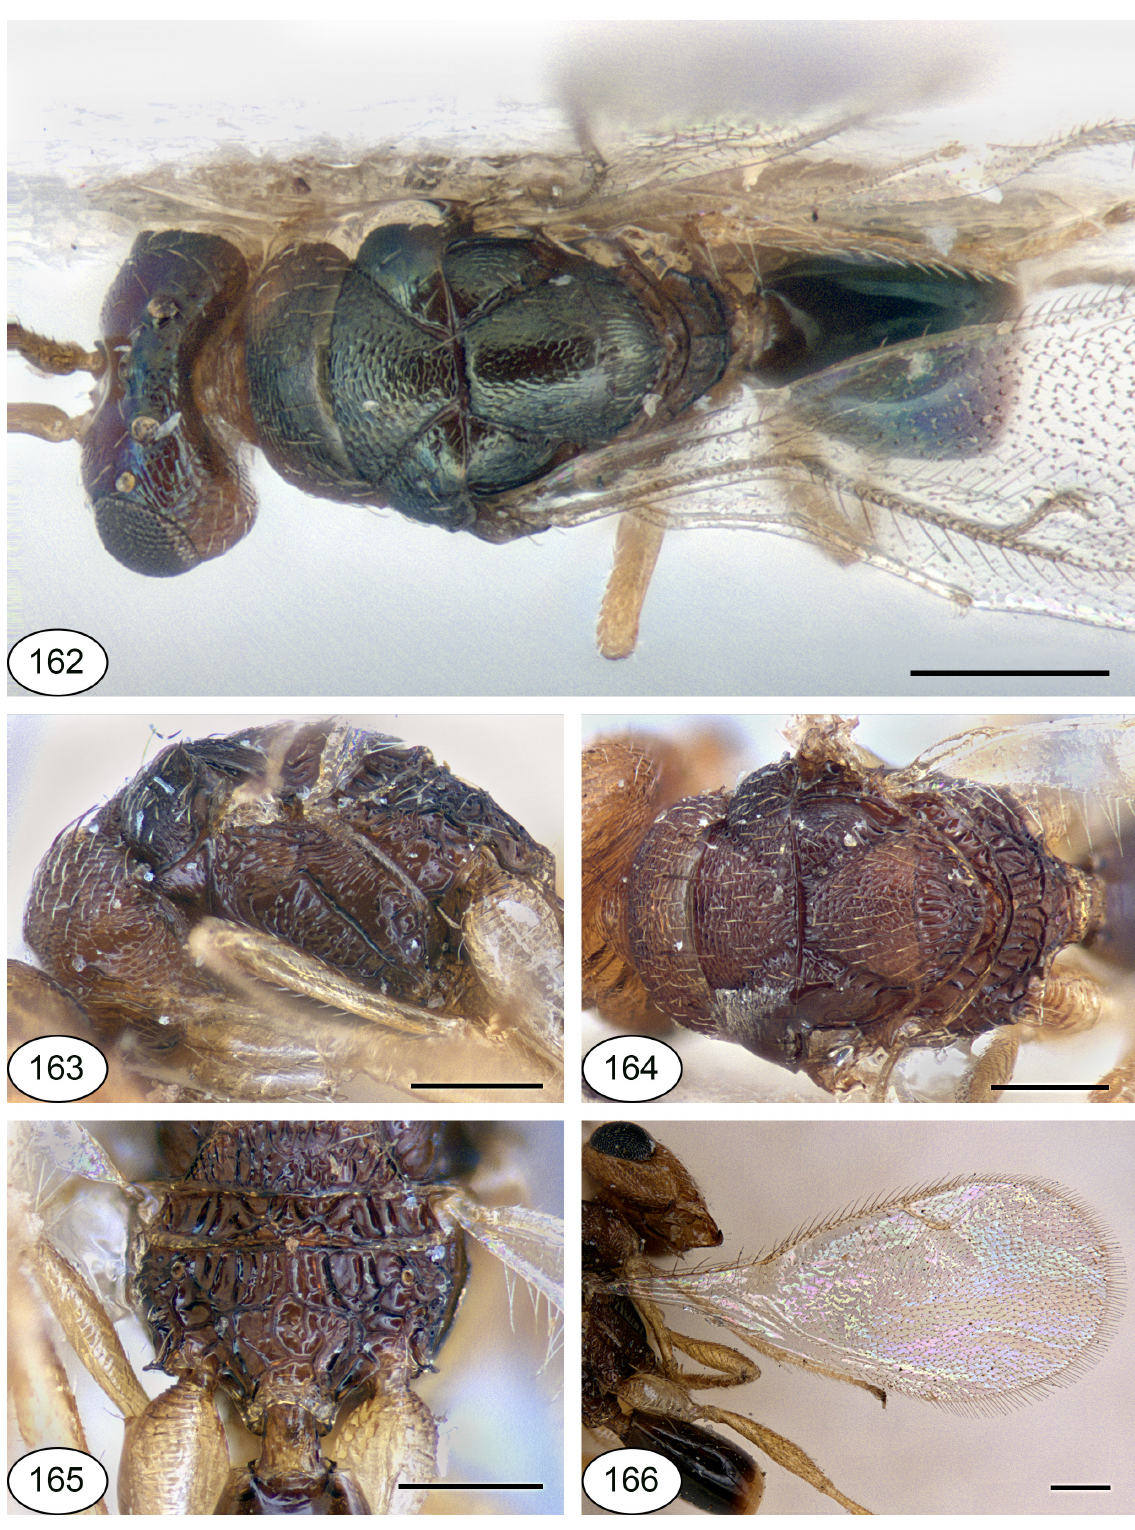
Figs 162–166. Netomocera rufa Hedqvist, 1971. 162 . ♂, Zimbabwe, habitus, dorsal view. 163 . Holotype, ♂, mesosoma, lateral view. 164 . Holotype, ♂, mesosoma, dorsal view. 165 . Holotype, ♂, propodeum, dorsal view. 166 . Holotype, ♂, fore wing. Scale bars: 0.2